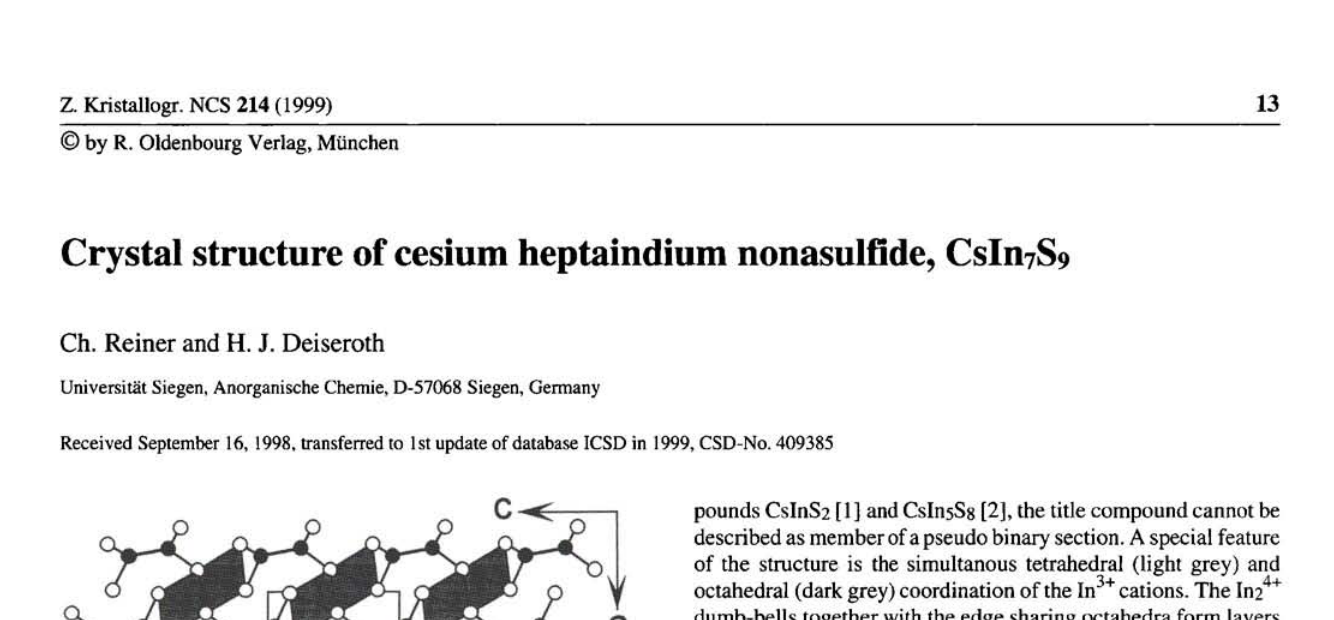
Table 1. Data collection and